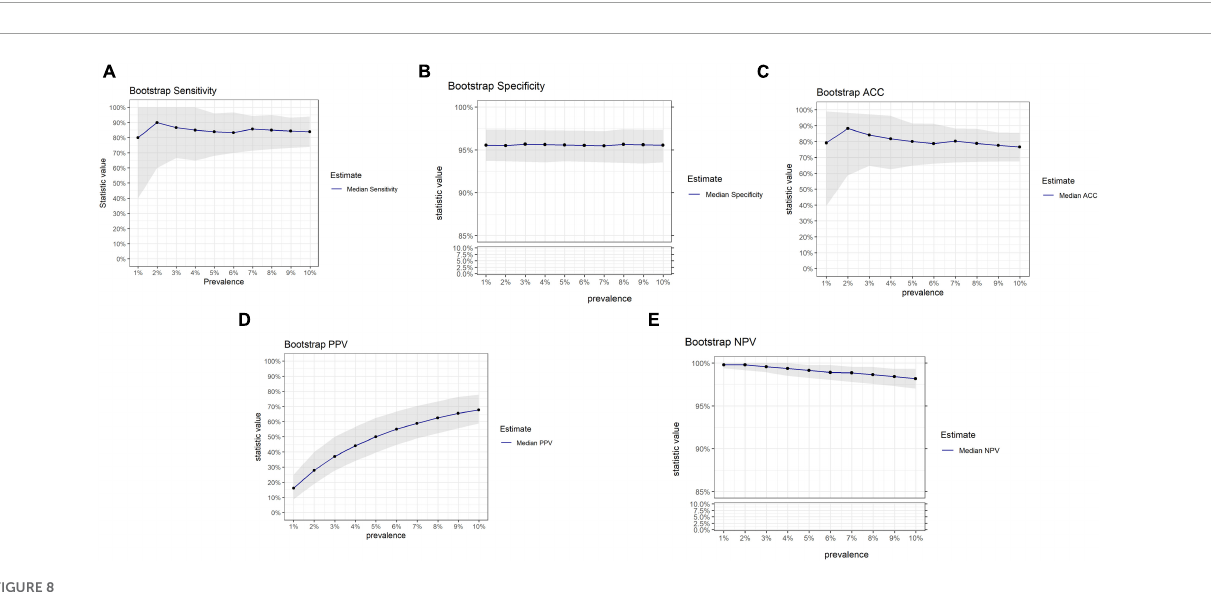
FIGURE8 Results of bootstrap analysis to evaluate the effects of prevalence on OVAWatch performance estimates and variability. Each statistic was estimated over 5,000 bootstrap samples at prevalence of 1–10%. The blue line represents the median estimated statistic, the gray band is the 2.5–97.5 percentile of the distributions. Bootstrap estimates are shown for sensitivity (A) , specificity (B) , Accuracy (C) , PPV (D) , and NPV (E) . Note y -axis breaks on panels (B,E) to emphasize prevalence dependent